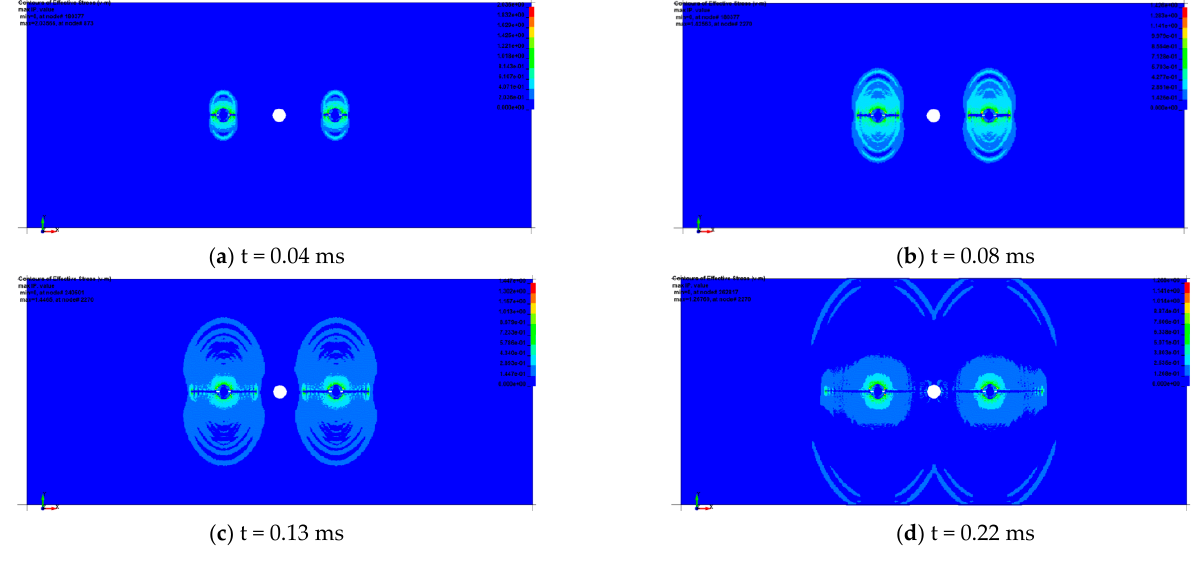
Figure 28. Stress evolution process of spaced-hole blasting with 200 mm spacing.